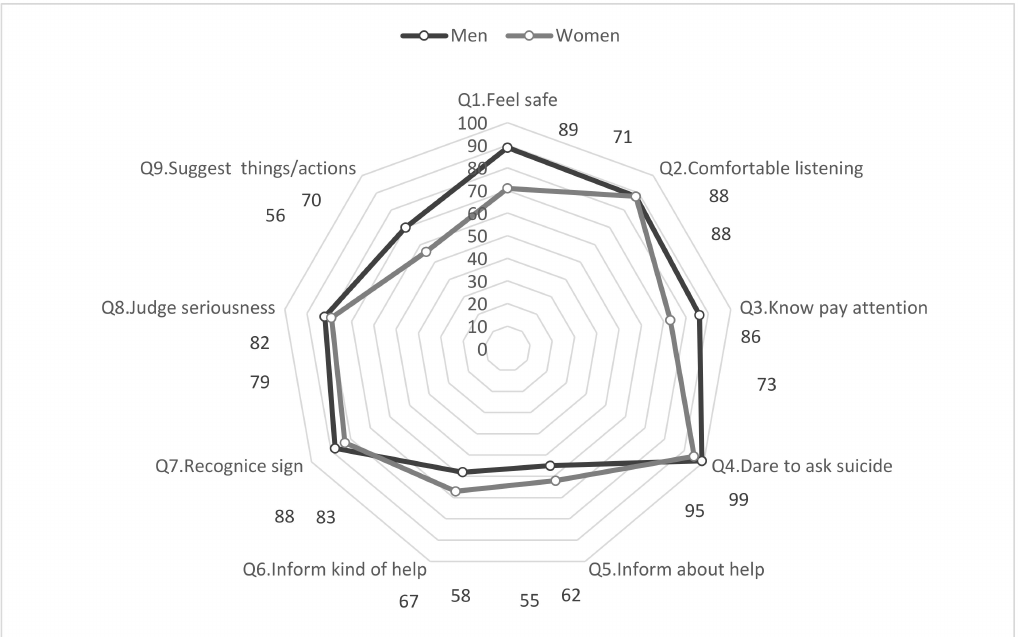
Figure 2. Response differences between men and women regarding the valuation of relative frequen- cies of positive response rates (Q-IV, response rates estimated according to a range from ‘to a fairly large extent’ through ‘to a very large extent’).